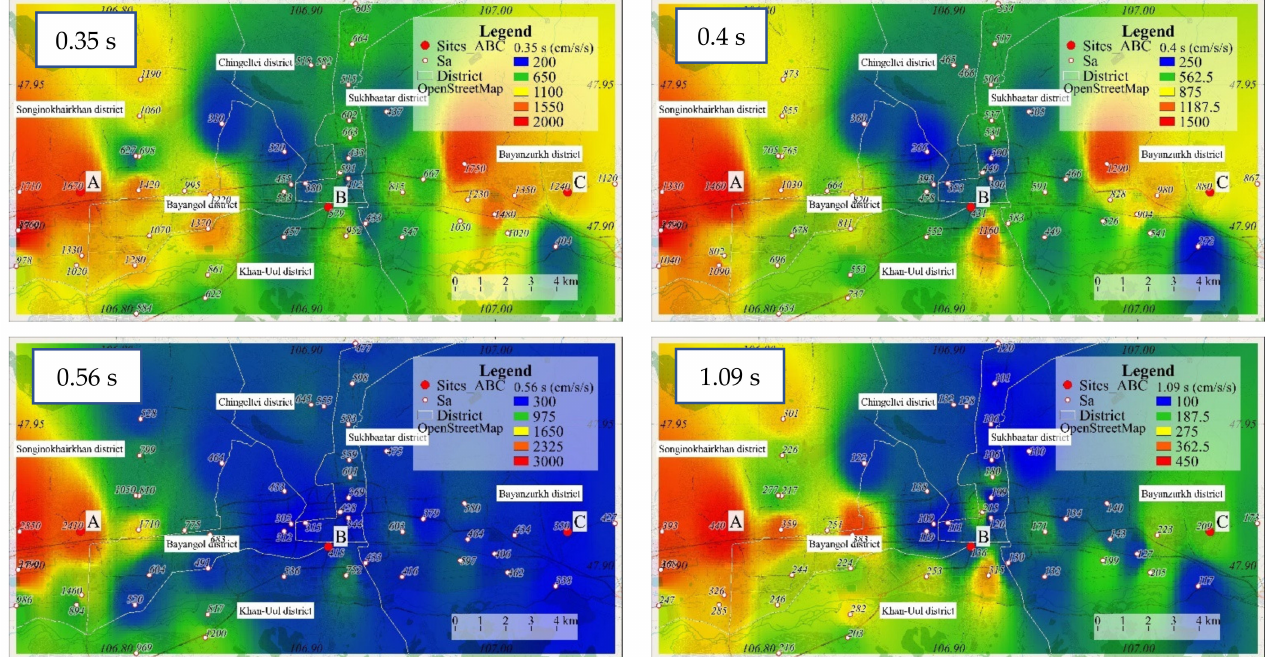
Figure 14. Distributions of spectral accelerations (Sa in cm/s 2 ) in UB at 0.35 s, 0.40 s, 0.56 s, and 1.09 s estimated from the Emeelt